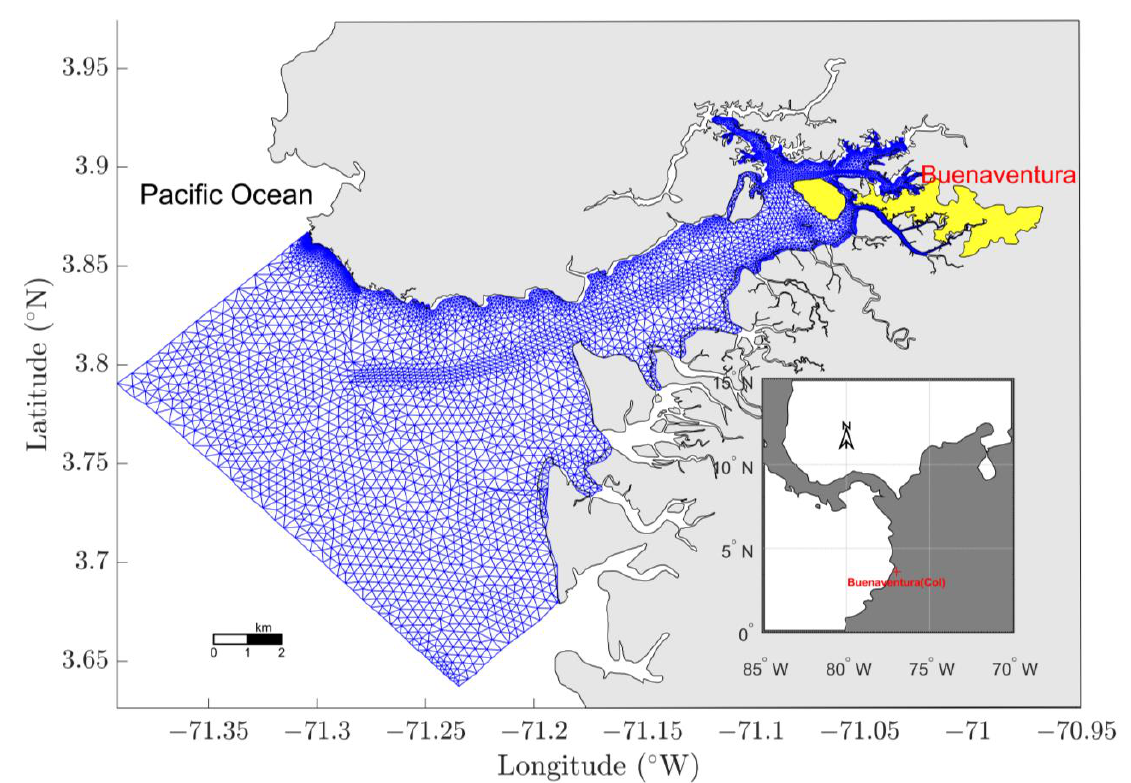
Figure 4. Buenaventura Bay finite element mesh (blue), urban area in yellow.